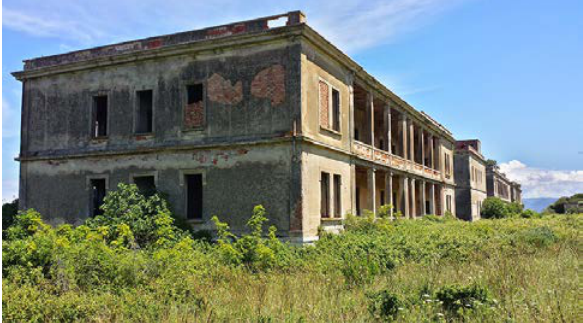
Figure 13. The fronts of the accommodation buildings along the main street